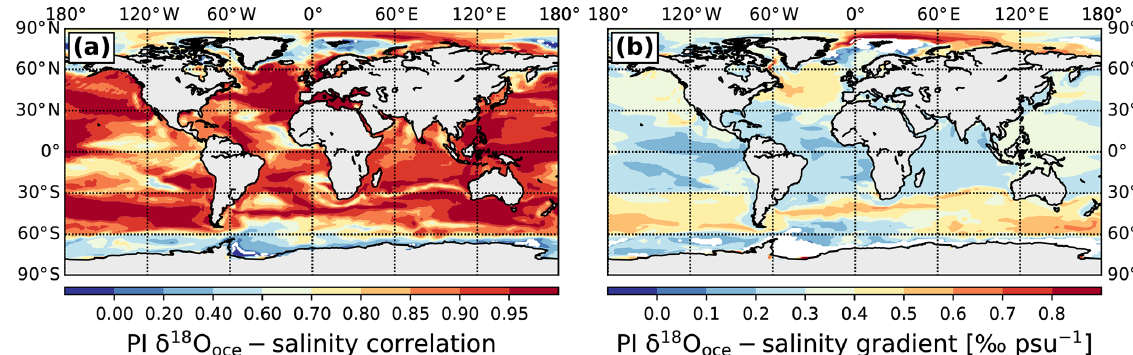
Figure 9. Correlation coefficients (a) and gradients (b) of the interannual relationship between monthly anomalies of δ 18 O oce in ocean surface water and salinity. All values shown are significant at the 95% level. The gradient values are only shown for correlation coefficients higher than